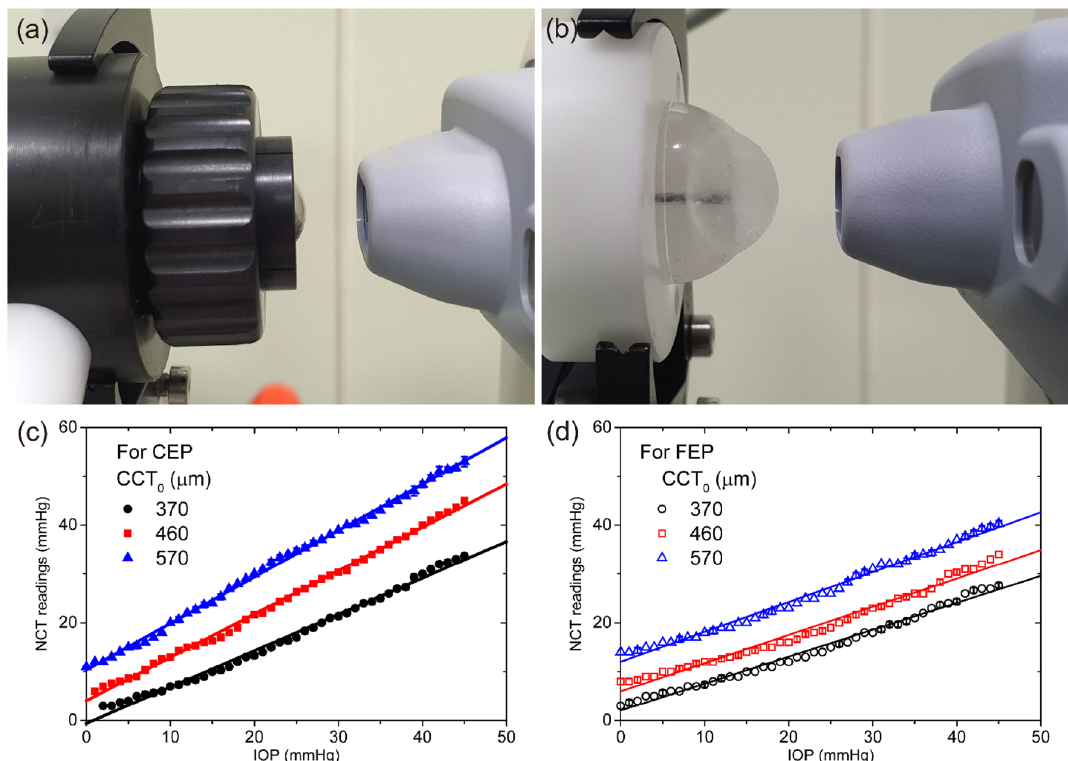
Figure 2. The experimental setup for measuring intraocular pressure with non-contact tonometer for the cornea eyeball phantom ( a ) and the full eyeball phantom ( b ). The relationships between the NCT readings and the IOP for the cornea and full eyeball phantoms are shown in ( c ) and ( d ),